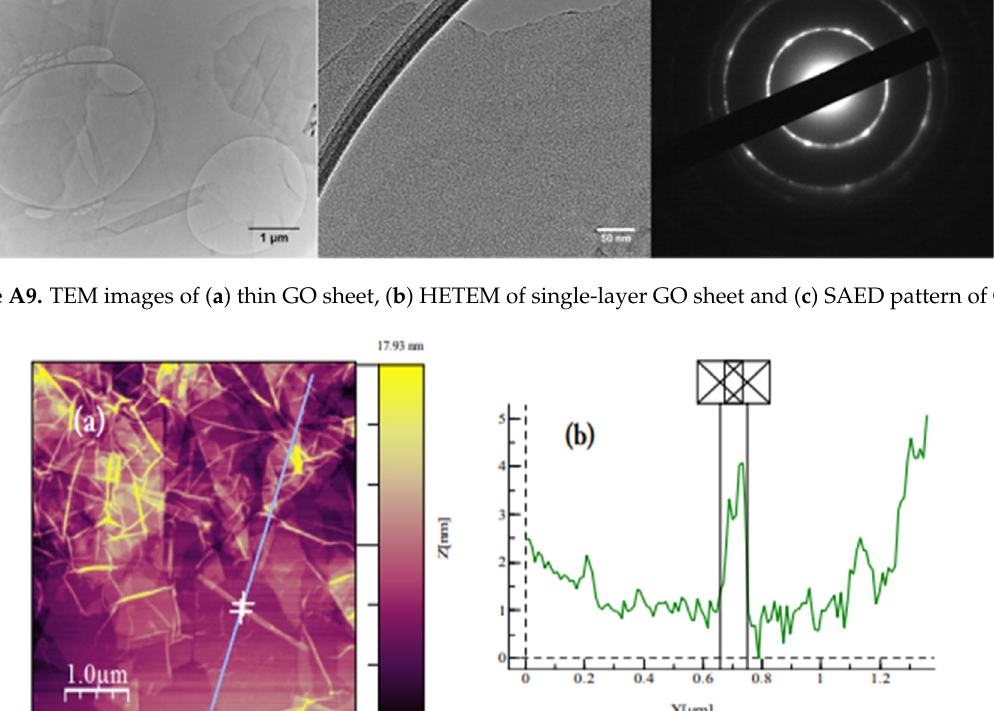
Figure A10. ( a ) AFM image of GO dispersion deposited on SiO 2 /Si substrate. GO sheets are expected to be around 1 nm thick due to the presence of covalently bonded oxygen and the displacement of the sp3 hybridized carbon atoms slightly above and below the original graphene basal plane 304. ( b ) Average thickness of ~0.8 nm according to the height profile.